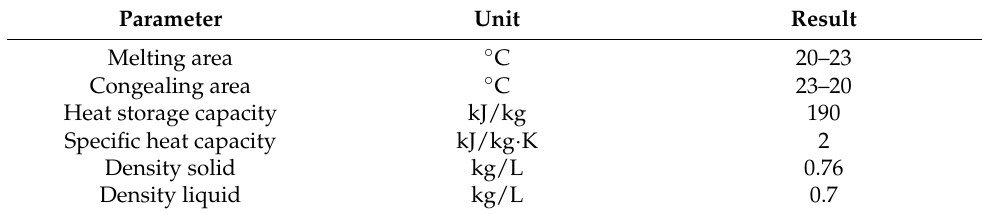
Table 2. Properties of parafin RT22HC used for